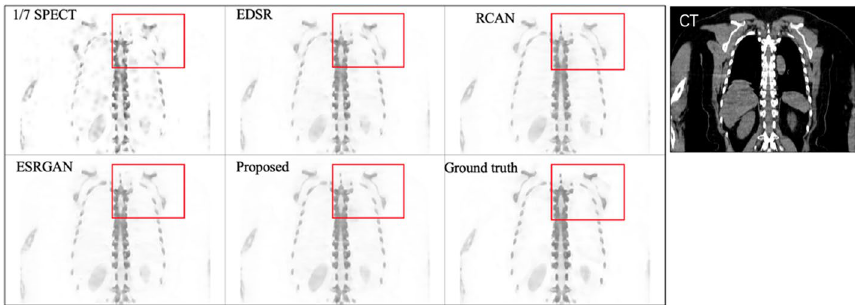
Fig. 3 Visual results of different methods on synthesizing standard SPECT from 1/7 SPECT. Please zoom in for a better comparison. The results are images from the same case using 1/7 scan time constructed with the OSCG algorithm, enhanced by EDSR network, RCAN network, ESRGAN network, proposed U 2 ‑Net, respectively, and the standard SPECT image